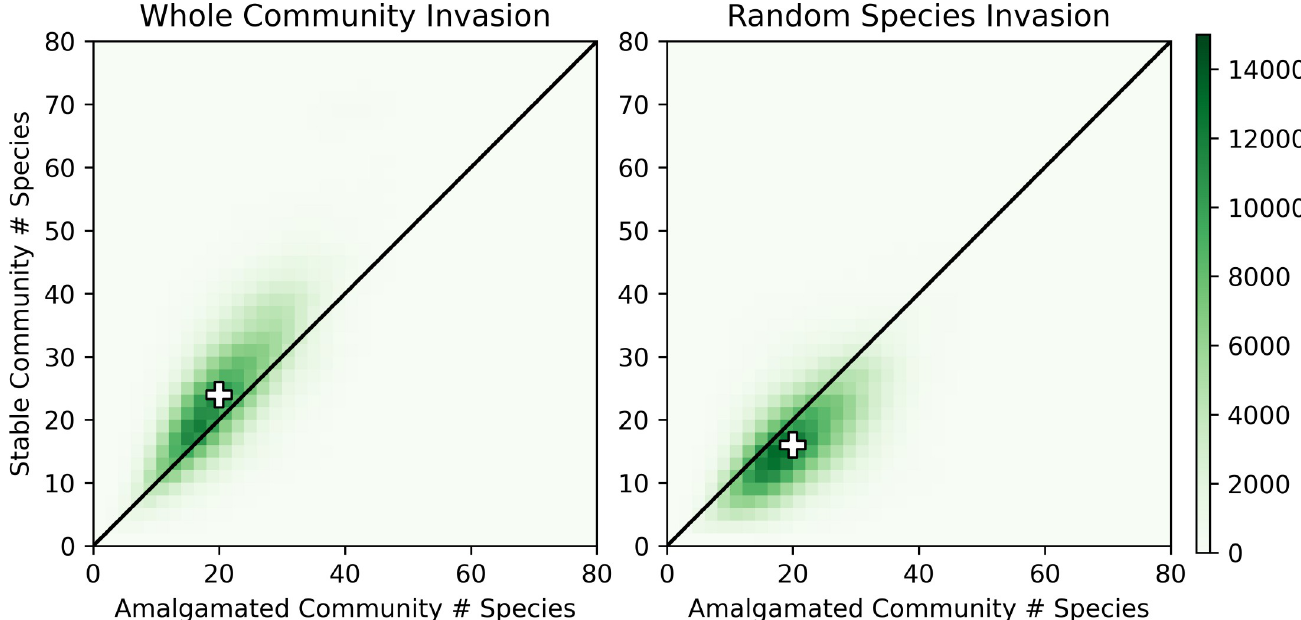
Fig 3. The effect of multi-species invasion on species richness. The horizontal axes indicate the total number of native and invasive species at the time of invasion (i.e., in the amalgamated community); the vertical axes indicate the total number of species in the resulting attractor (stable state or limit cycle). Coloring indicates the number of simulations with the corresponding species counts. The black line indicates a 1:1 ratio for visual reference and the “+” symbol indicates the median. When the invaders form a stable community (left), the species richness generally increases. In contrast, if the invaders do not form a stable community (right), the species richness generally